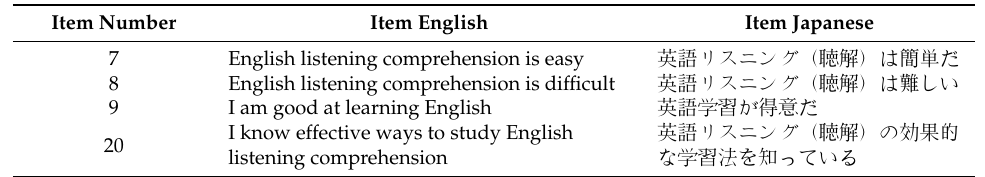
Table A2. Linguistic Self-Confidence.